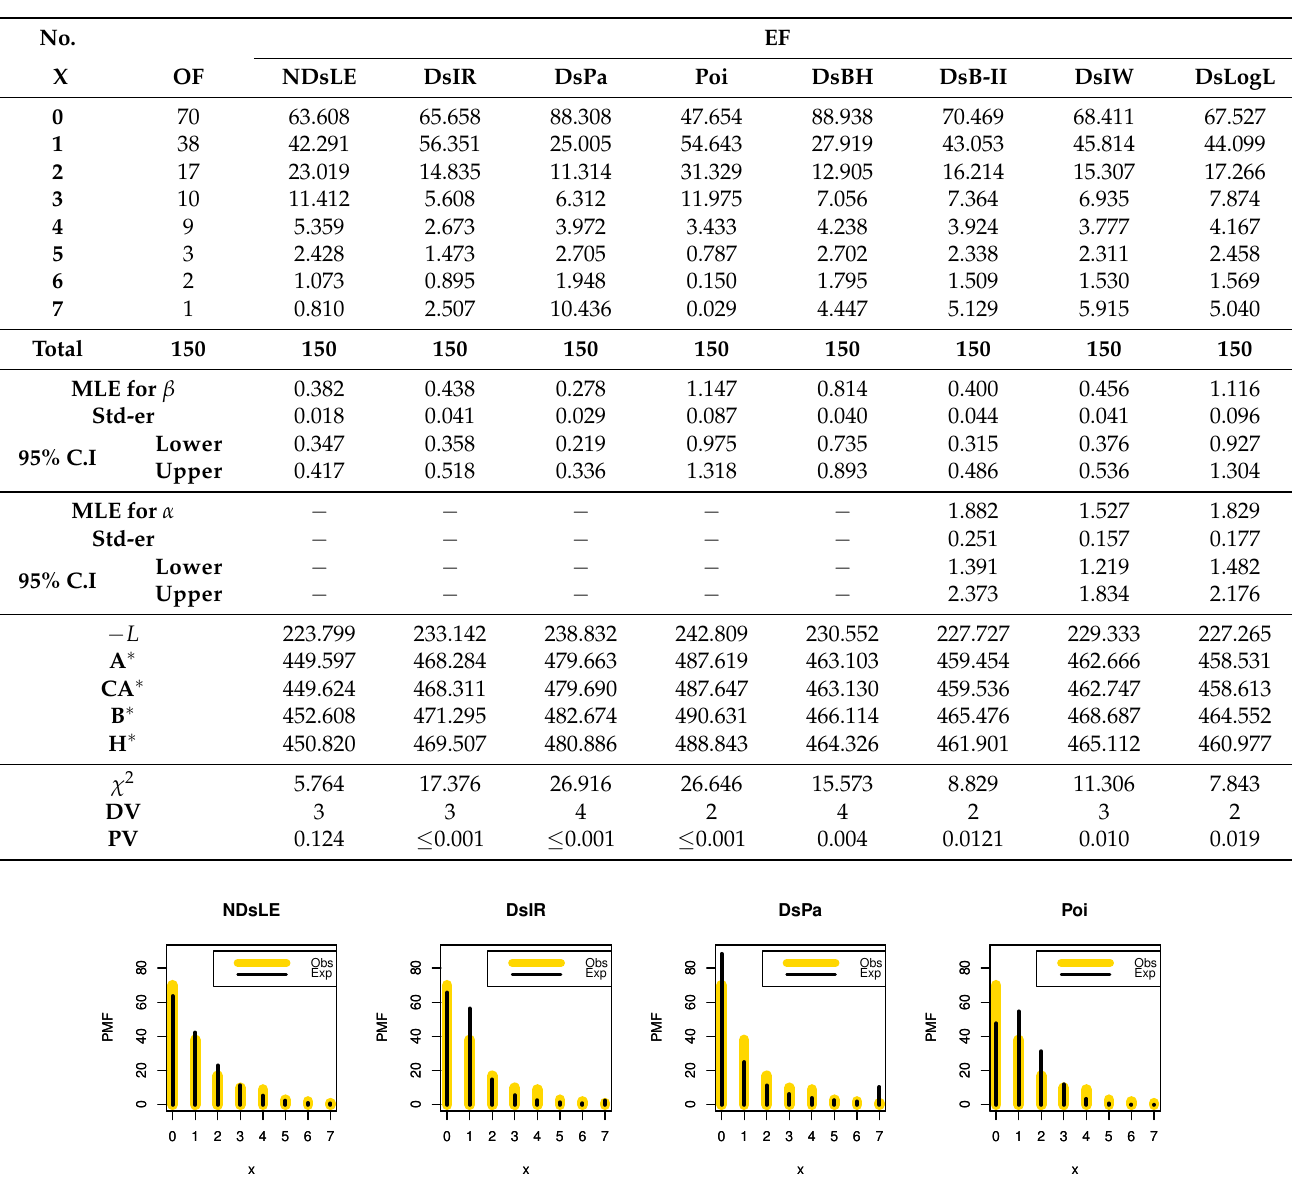
Table 6. The MLEs, Std-er, C.I, and GOF measures for data set I.